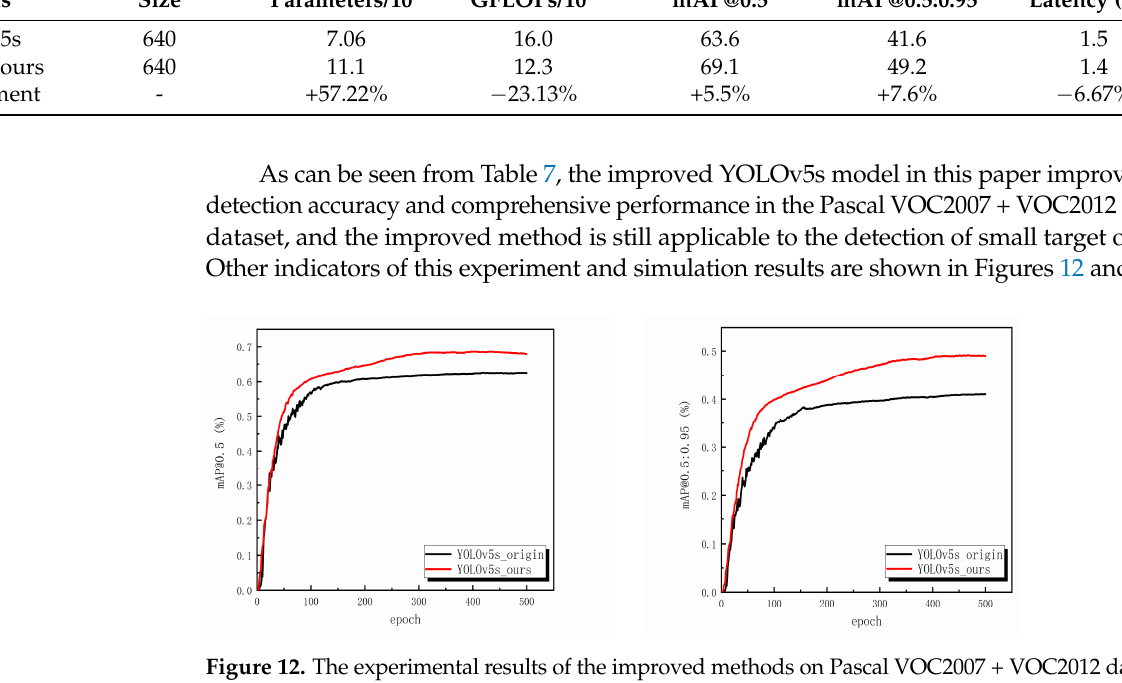
Figure 12. The experimental results of the improved methods on Pascal VOC2007 + VOC2012 da- tasets.